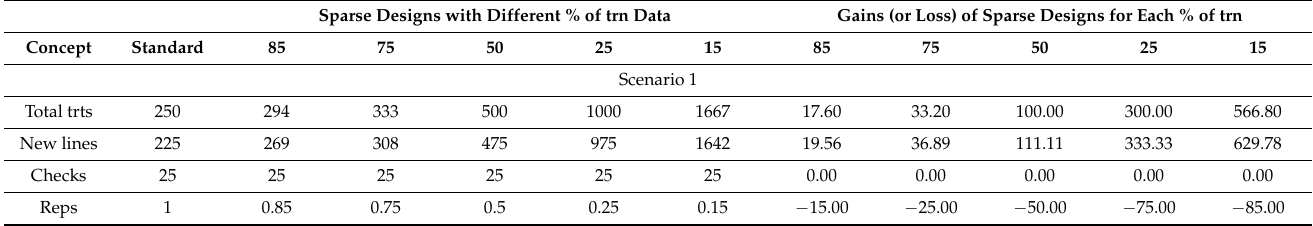
Table 1. Gains or loss of using sparse methods (Incomplete designs) regarding conventional method (Standard) with di ff erent % of training sets (trn) using 4500 and 250 lines.